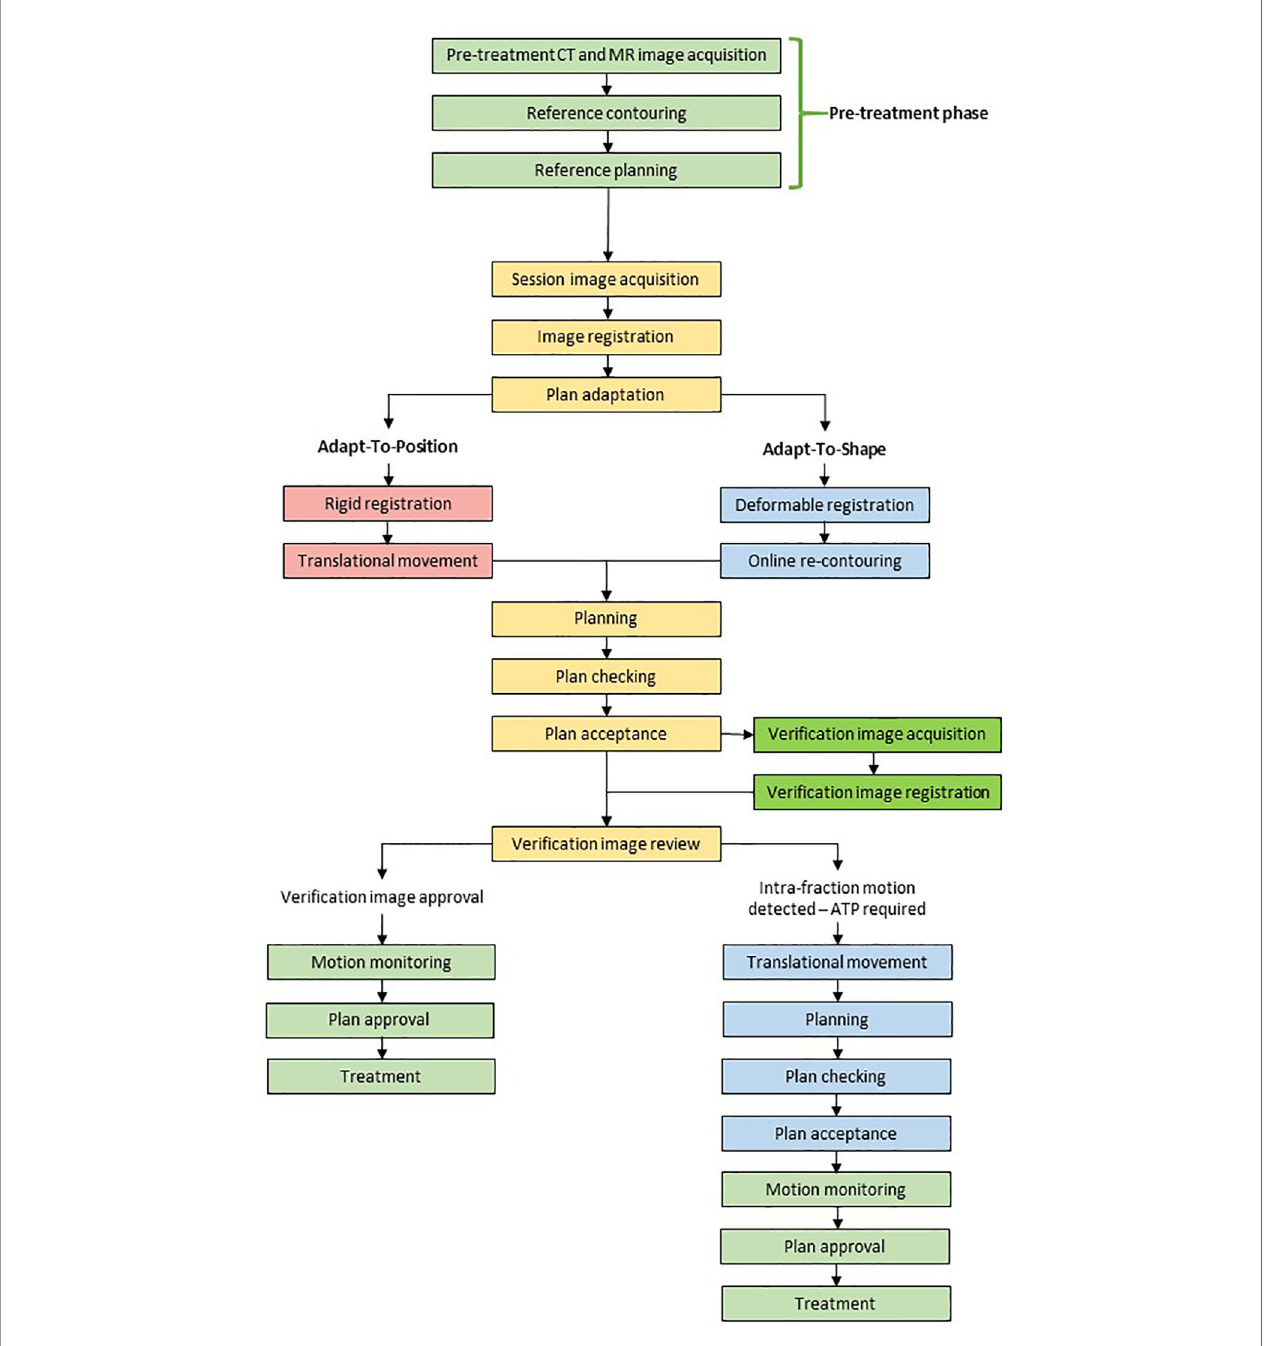
FIGURE 3 | Example work fl ow for the